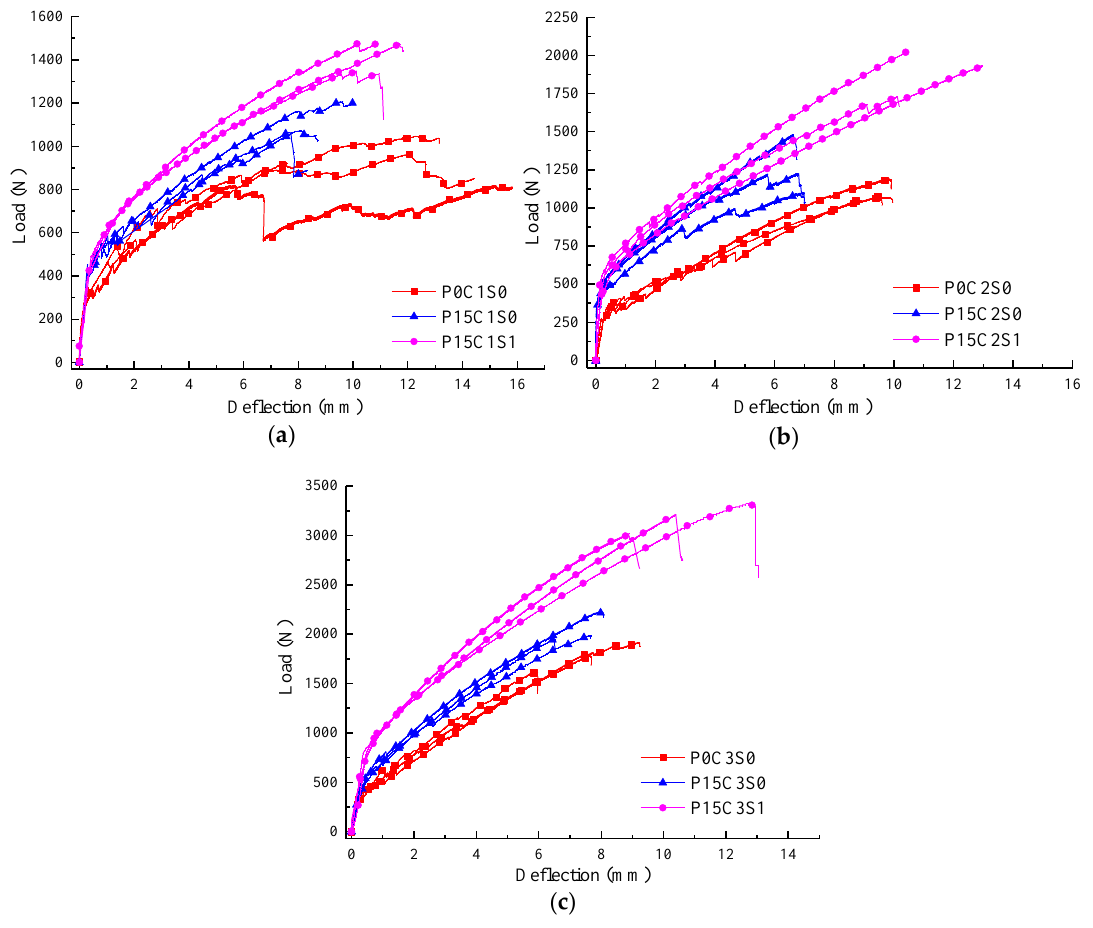
Figure 19. Load-deflection curves of the ( a ) one-layer, ( b ) two-layer and ( c ) three-layer prestressed TRC specimens with 0% and 1% volume contents of steel fibres.